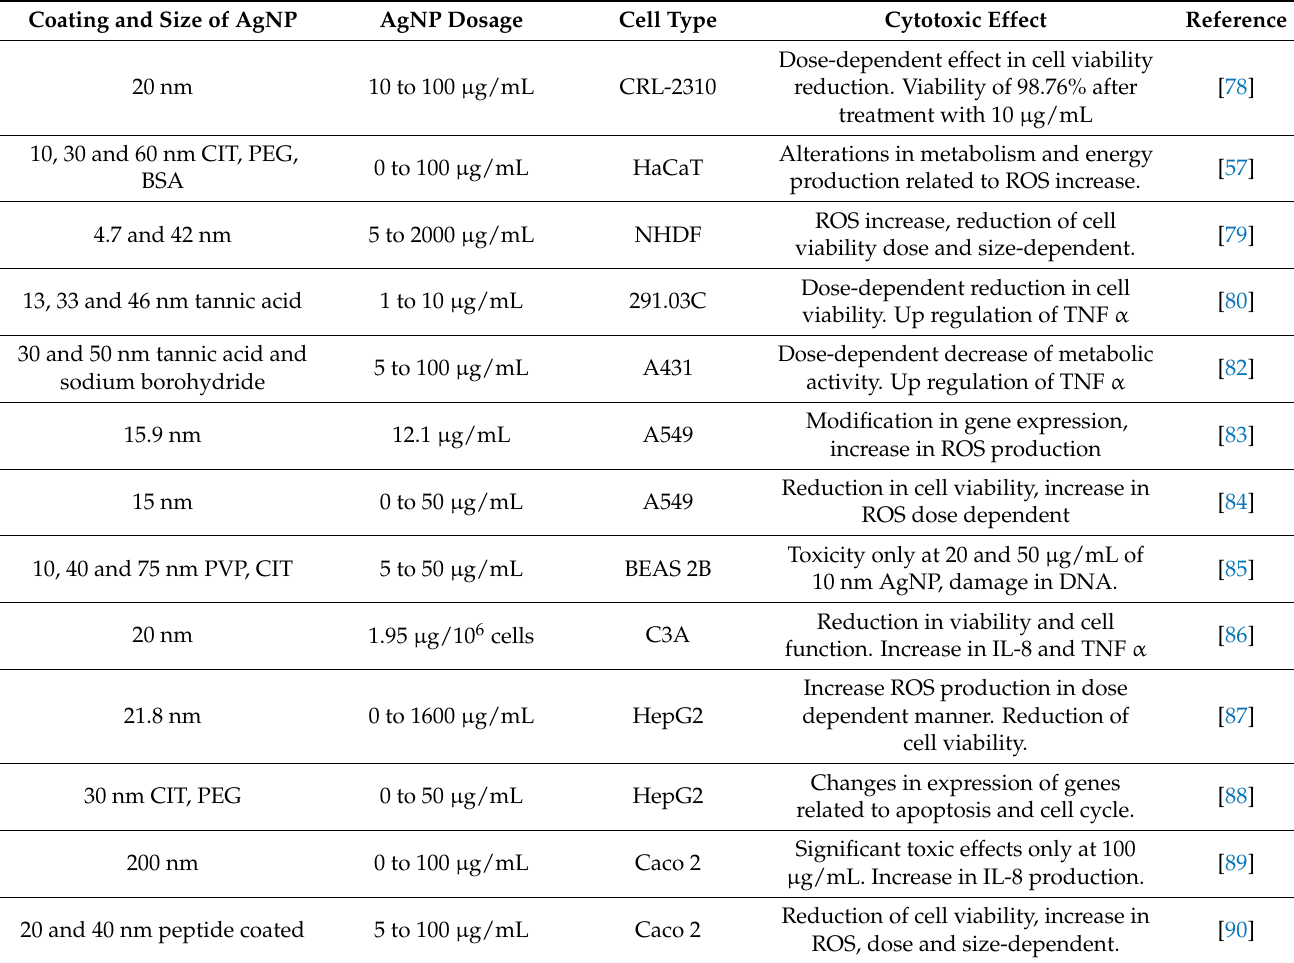
Table 2. Resume of cytotoxic effects registered in mammalian cell lines after exposure to different doses of AgNPs. Coating and Size of AgNP AgNP Dosage Cell Type Cytotoxic Effect Reference Dose-dependent effect in cell viability 20 nm 10 to 100 µ g/mL CRL-2310 reduction. Viability of 98.76% after treatment with 10 µ